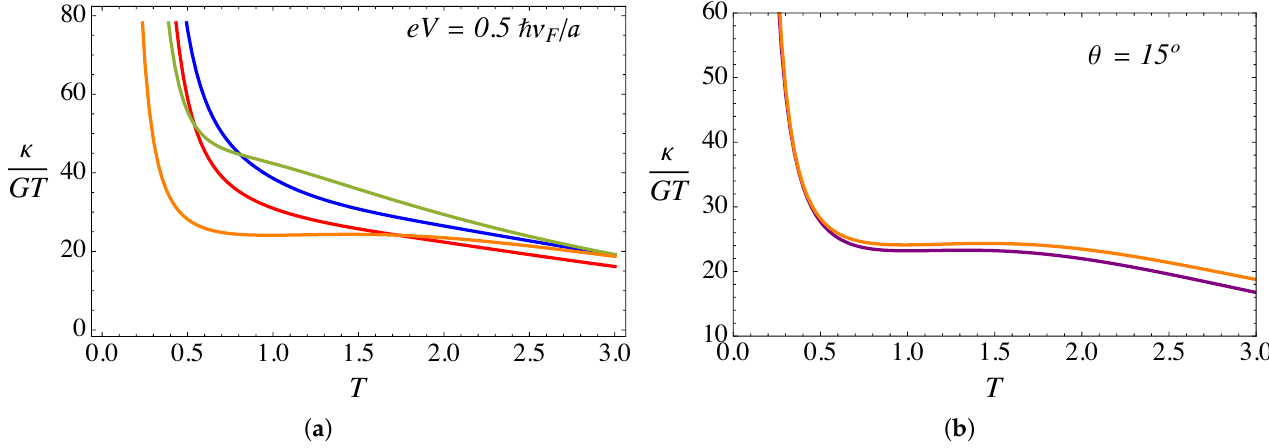
Figure 13. (Color online) ( a ) The Lorenz number (in units of k 2 / e 2 ) as a function of temperature (in units of ¯ h v F / k B a ), B calculated for fixed B 0 a 2 = 25 ˜ φ 0 , a bias eV = 0.5 ¯ hv F / a and α = 3 π /4. The blue line corresponds to θ = 0 ◦ , red is for θ = 5 ◦ , green is for θ = 10 ◦ , and the orange line corresponds to θ = 15 ◦ . ( b ) Comparison of the Lorenz number for θ = 15 ◦ : the purple line is for α = 0 whereas the orange line is for α = 3 π